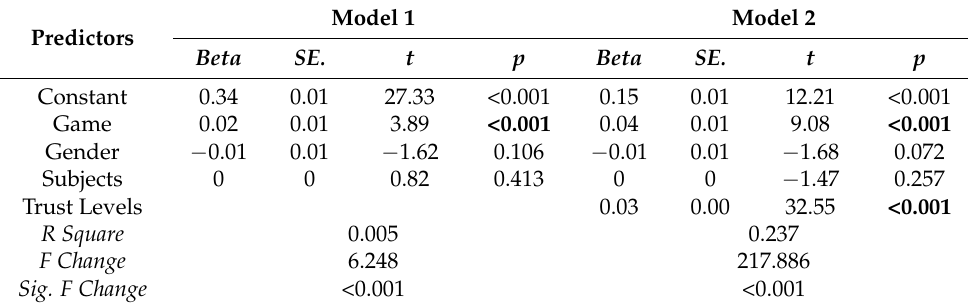
Table 2. Hierarchical linear regression analysis on expected percentage of